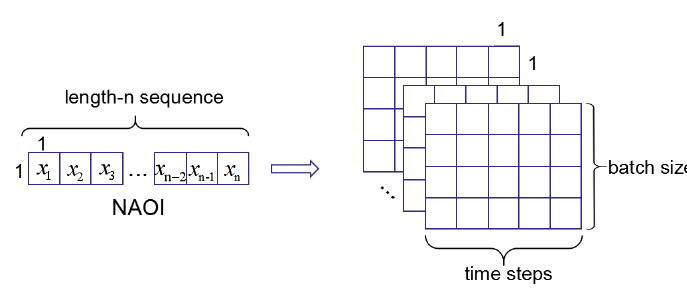
Figure 2. The input shape of